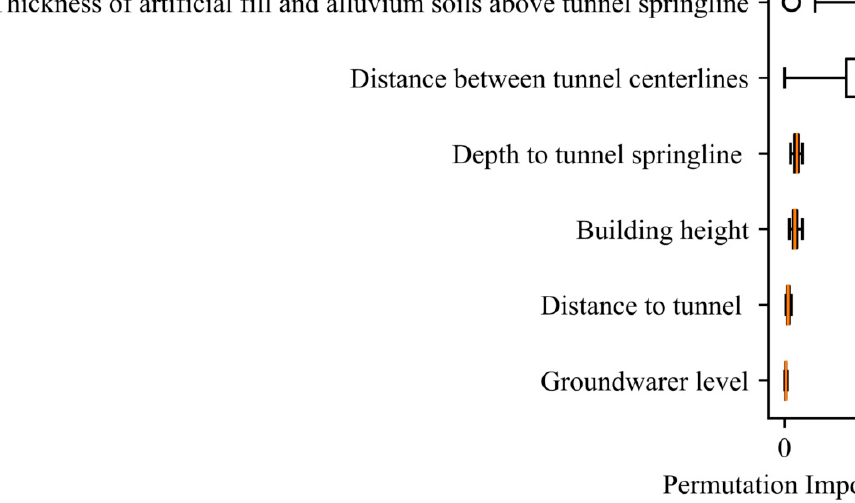
Figure 10. Parametric analysis of above- and underground features.